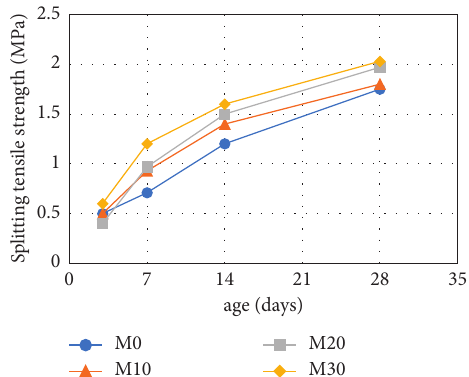
Figure 7: Effect of crushed brick ratio on splitting tensile strength of